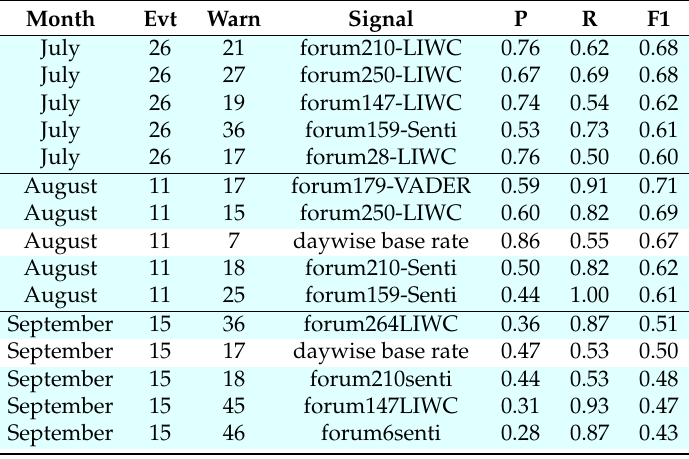
Table A3. Results from Organization A’s malicious